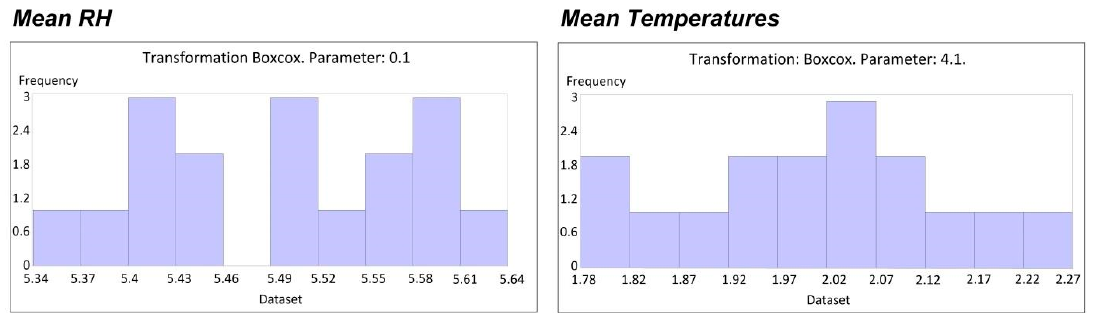
Figure 3 . Transformed histograms for mean RH and mean temperature . Figure 3. Transformed histograms for mean RH and mean Spatial trends for both temperature and RH were calculated as second-order poly- nomial distributions for three of the space orientations (North–South and West–East) and as a first-order polynomial distribution for one of the sides of the mean RH (West– East). A trend transformation or detrending was subsequently performed with respect to the higher order found on the three axes. A careful observation of the polynomials rep- resented indicates that the lines begin at high values that decrease in trend, as there is a scrolling from south to north that increases as it moves west from the center of the do- main in the case of mean temperature. In Figure 4, semivariograms with the adjusted functions using the EBK regression prediction for wind speed and PM 2.5 are shown, and in Figure 5, the semivariograms corrected for mean temperature and mean RH are presented. Figure 4. Adjusted semivariograms for PM 2.5 and mean wind speed .